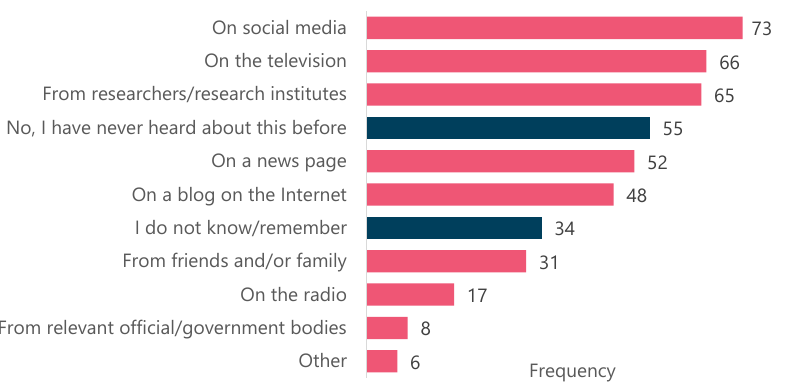
Figure 3. Knowledge items with answer distribution from highest to lowest level of agreement (* represent a false claim). Subjects were also asked if and where they have heard that research has shown that synthetic ingredients are harmful to corals and other marine life (Figure 4). A total of 63.9% said they had known about this information. Most of them learned about it from social media ( f = 73), television ( f = 66), and researchers or research institutes ( f = 65).